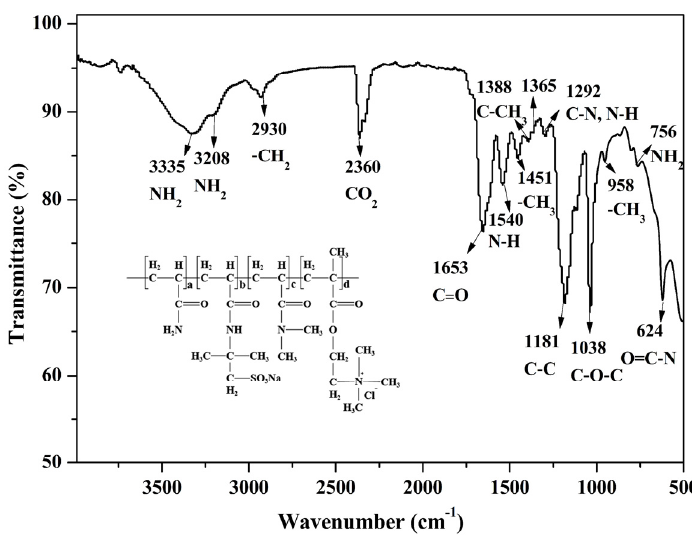
Figure 2. 1 H NMR spectrum of PADAD.